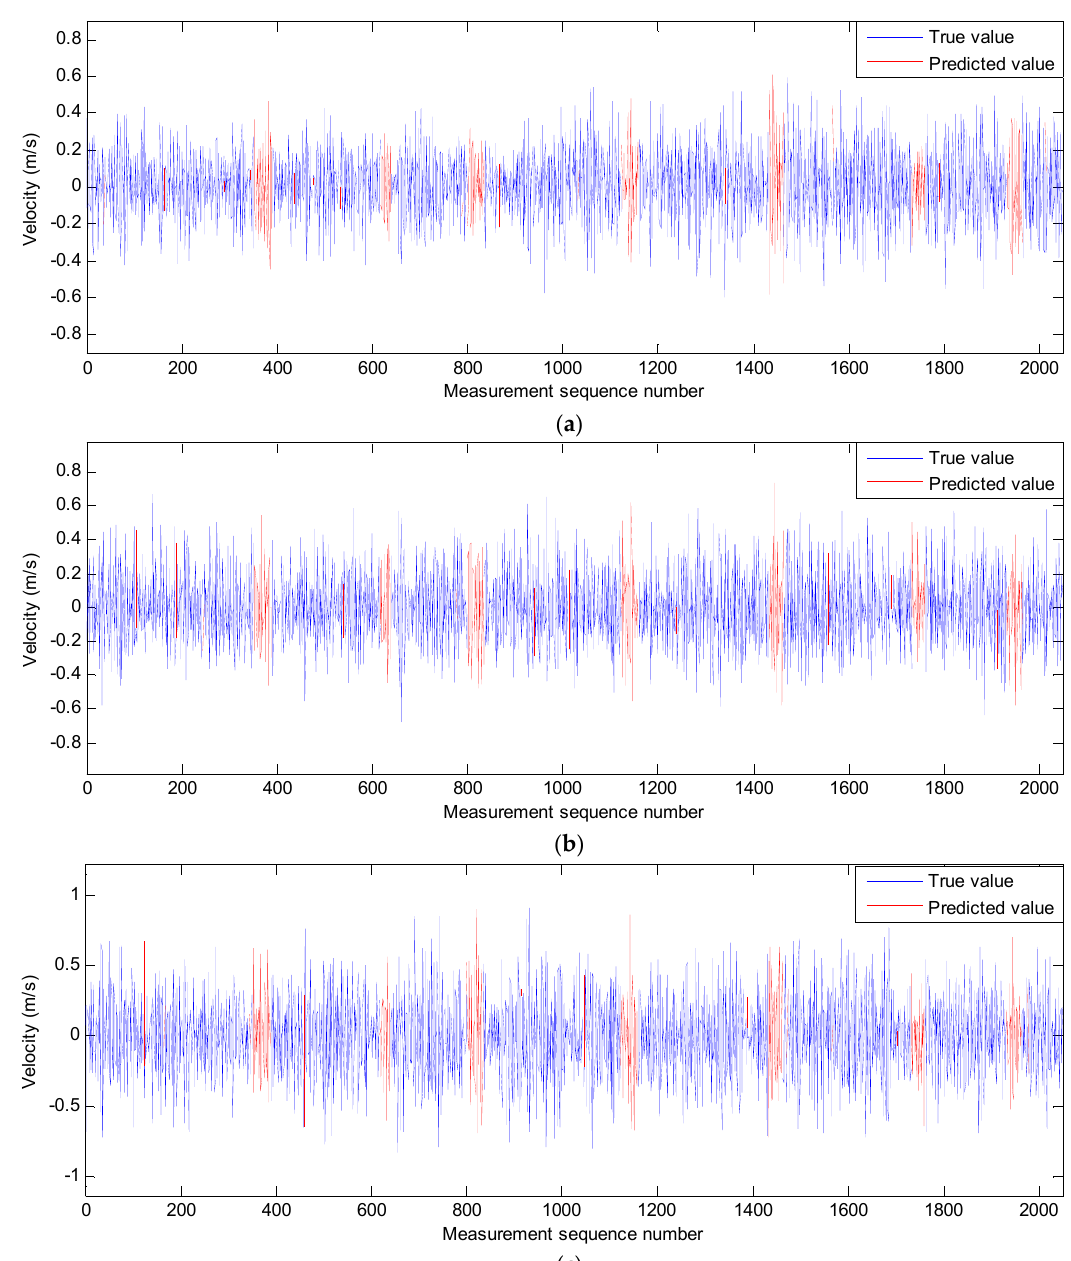
Figure 9. Movement velocity data sequences of the SBF7-1A GPS wave buoy in three directions after correction at 03:00 (UTC) on 2 July 2013: ( a ) movement velocity data sequence in the east-west direction; ( b ) movement velocity data sequence in the north–south direction; ( c ) movement velocity data sequence in the vertical direction.